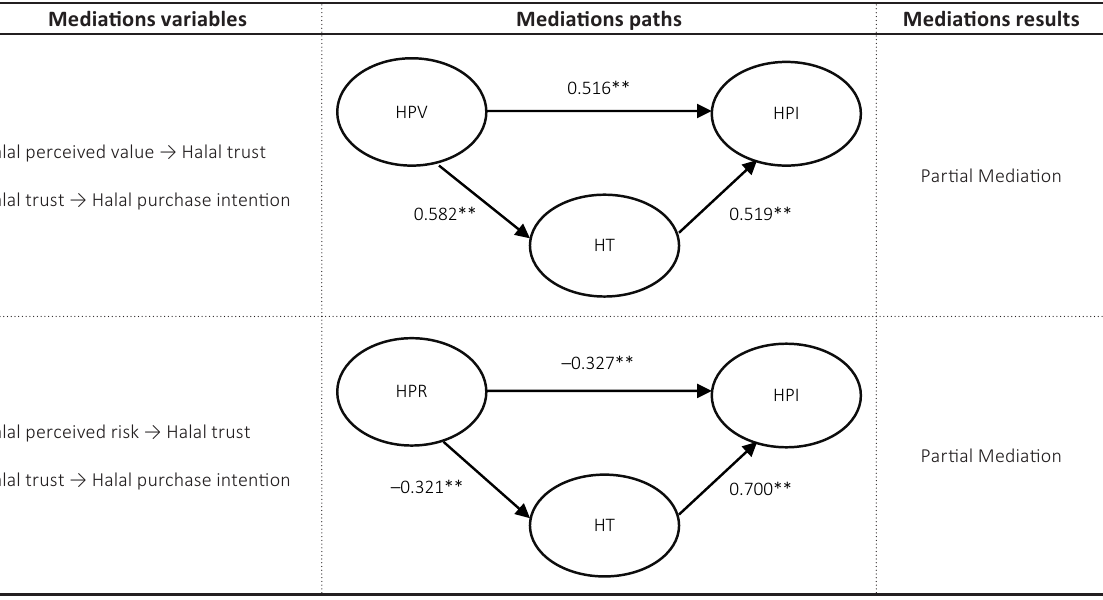
Table 5. Mediation path